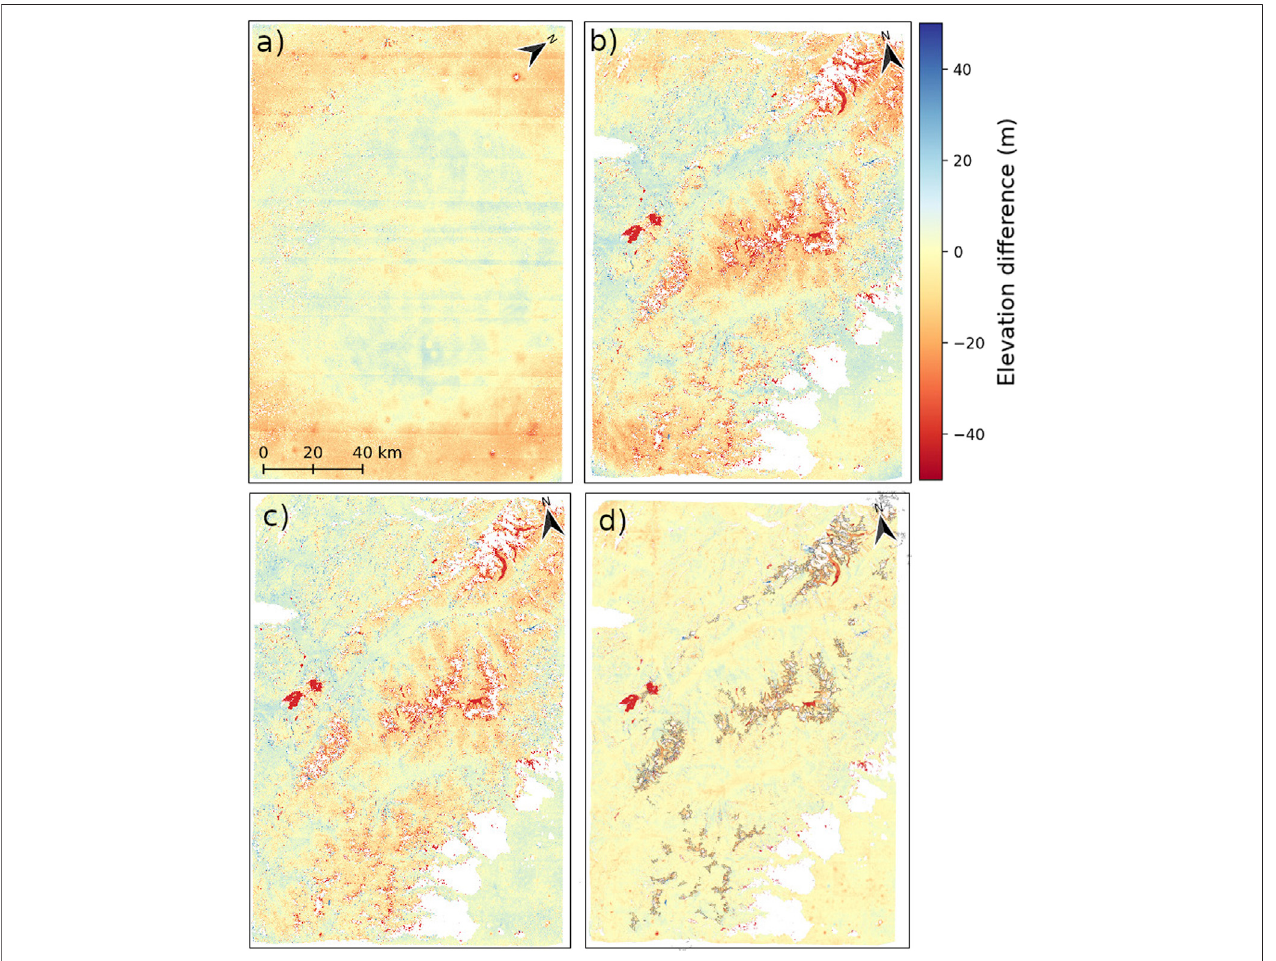
FIGURE 4 | Examples of residual elevation biases in co-registered KH-9 MC DEMs before the re fi nement of camera intrinsic parameters. (A) “ Bull ’ s eye ” pattern caused by the lens distortion visible over fl at terrain (pair DZB1212-500129-002/003) (B) Elevation biases correlated with topography over the central European Alps (pair DZB1216-500312-002/003). The high-elevation mountains appear higher than the reference DEM (red) whereas low-elevation valleys appear lower (blue). (C) Sameas (B) butafterlensdistortioncorrection. (D) Sameas (B) butafterlensdistortionandfocallengthcorrection.Onthispanelonly,glaciersareoutlinedinblack. North direction in each panel indicated by a black